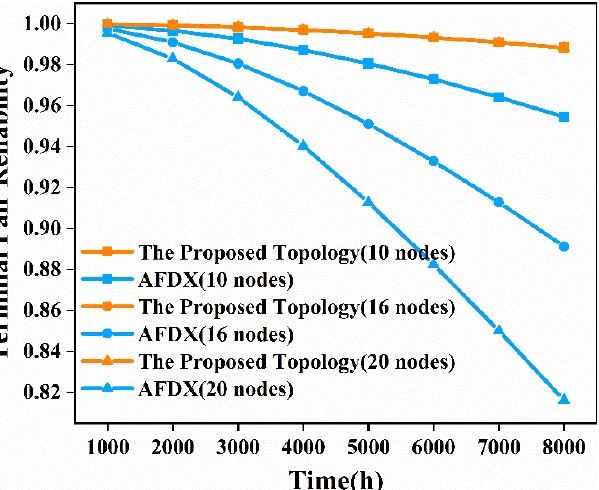
Figure 8. Time ‐ dependent terminal pair reliability comparison diagram of the proposed topology and AFDX in the three scenarios. and AFDX in the three